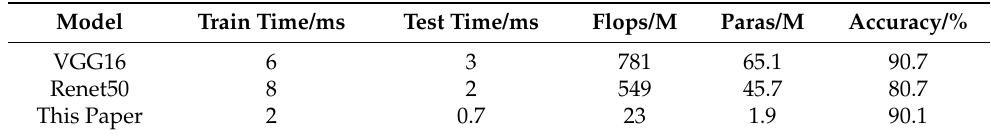
Table 4. Classification performance of single-channel classification network with different feature extraction